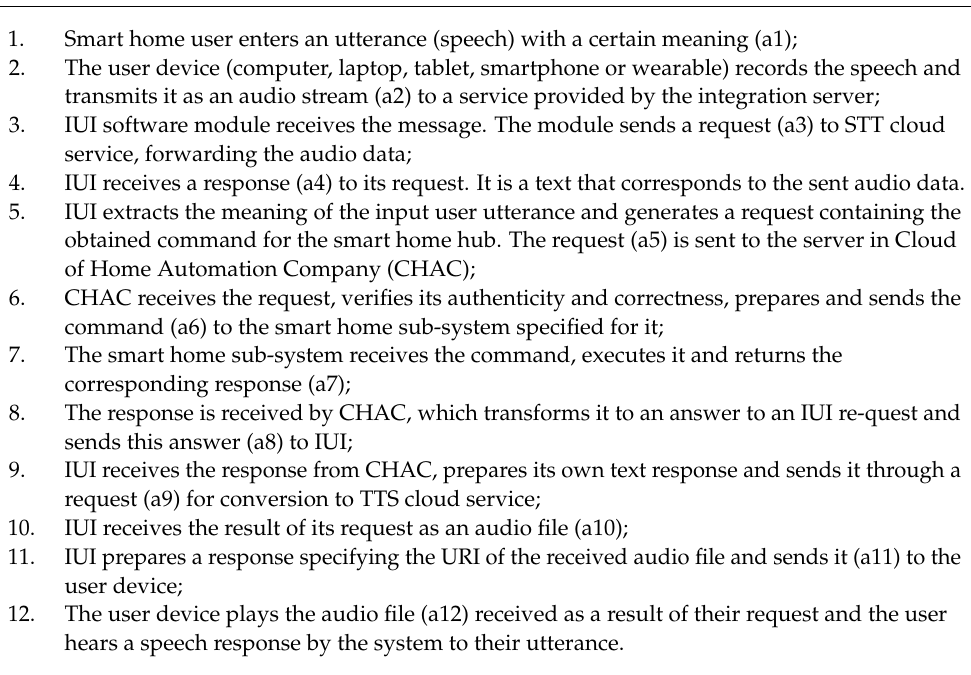
Algorithm 1 User–smart home system interactions via speech command as a part of SUI